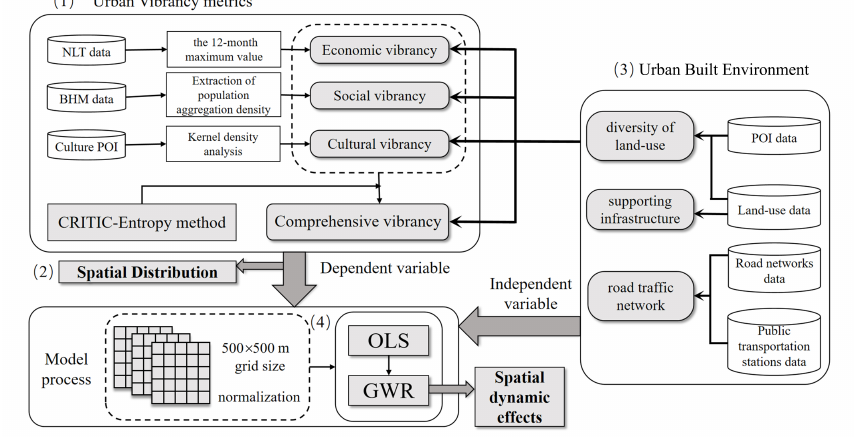
Figure 2. Research